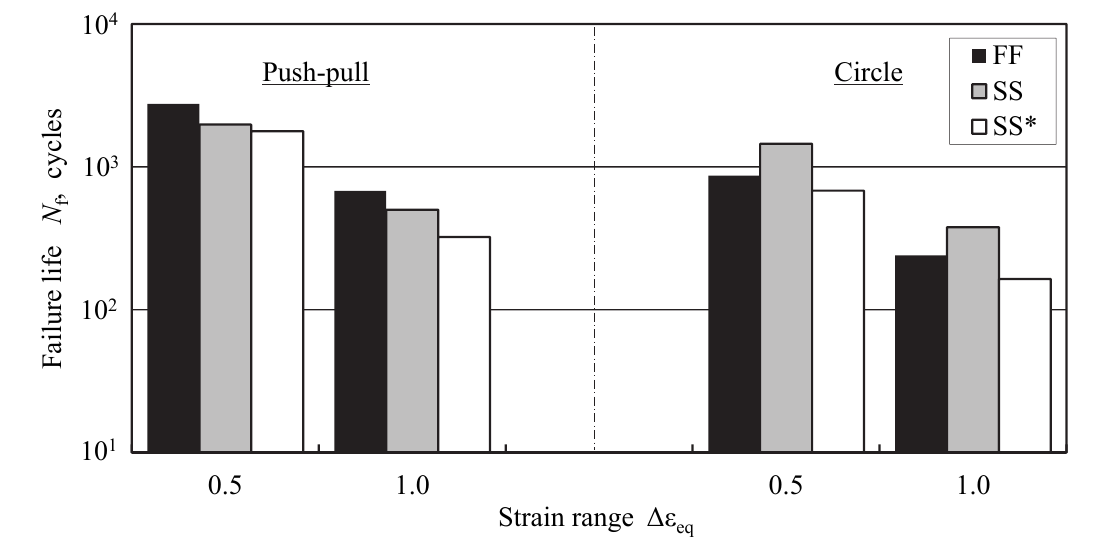
Figure 3: Comparison of creep-fatigue failure lives.